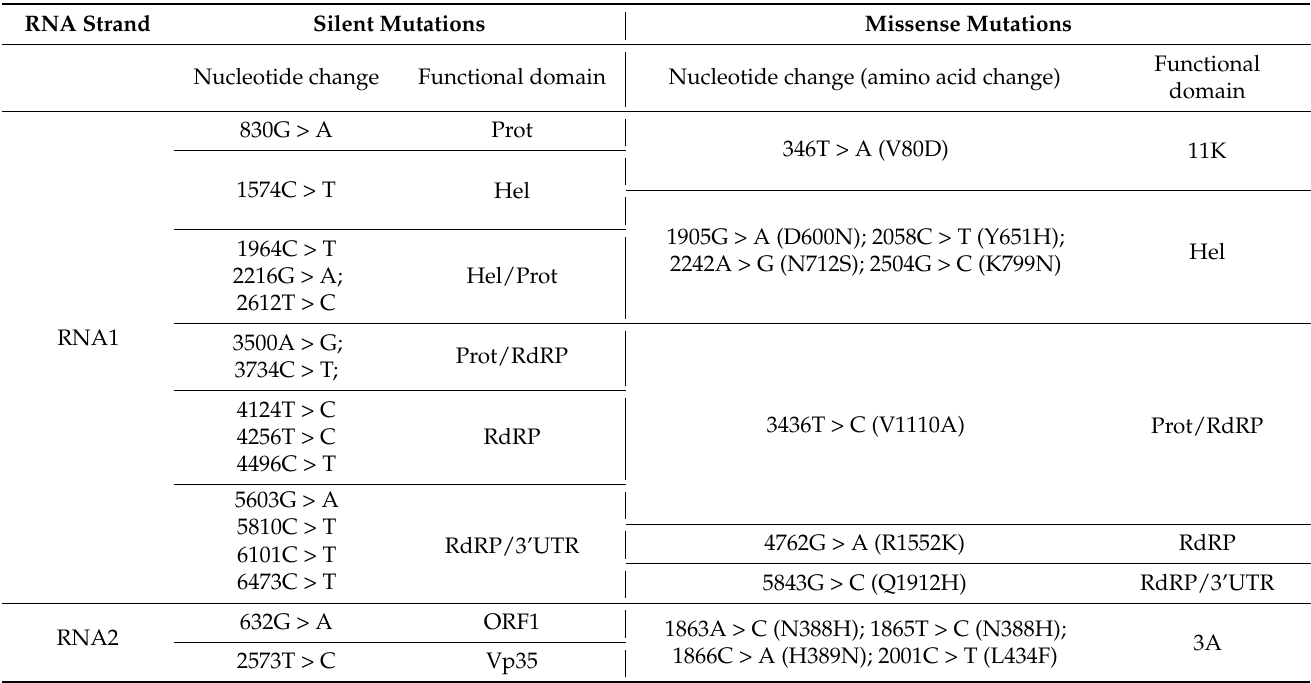
Table 1. The nucleotide (nt) and amino acid (aa) substitutions in particular functional fragments of RNA1 and RNA2 of tomato torrado virus Wal’17 isolate (MW729382, MW729383) in comparison to the original ToTV-Wal’03 (EU563948, EU563947)